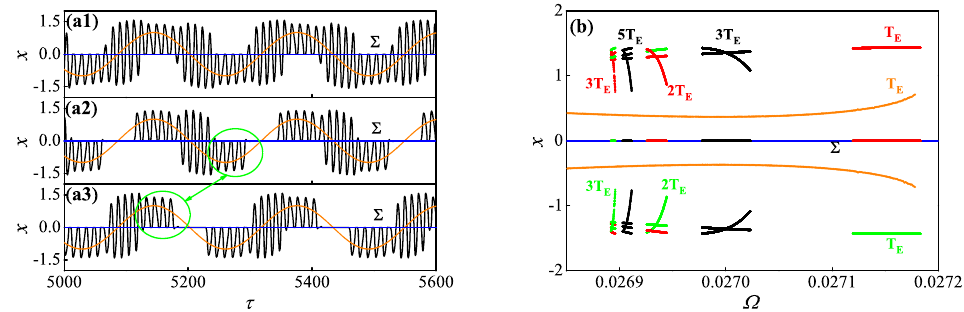
Figure 12. Coexisting responses when Ω = 0.027174 as well as the Poincaré map of whole system. ( a ) The three coexisting period–1 T E responses when Ω = 0.027174; ( b ) the Poincaré map of whole system on the section Π 1 : = w = 0 with Ω ∈ ( 0.02685,0.027183 )